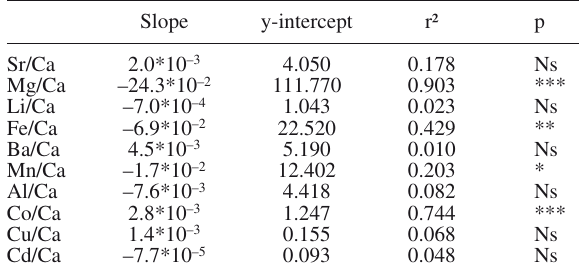
Fig . 3. – Mean (±sd) of isotopic ratios by site (R Sh, Rhône shal- low; R deep, Rhône deep). Both years in Thau coastal lagoon are grouped. Life stages are mentioned below the graphics Table 4. – Results of linear regressions between elemental compo- sition and fish size (TL) in the River Rhône mouth.